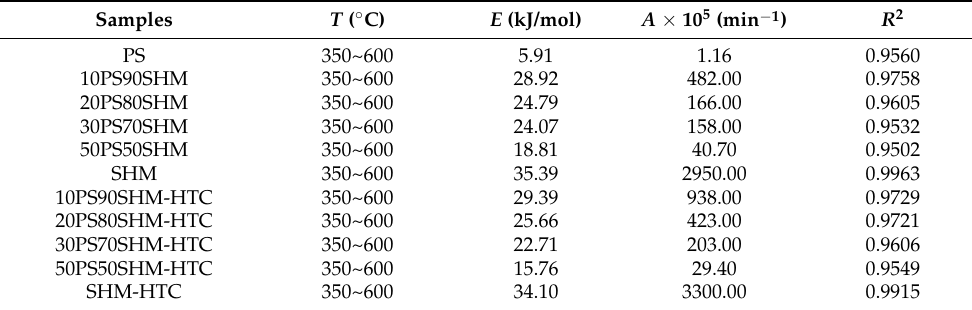
Table 4. Calculation results of kinetic parameters for PS, SHM, SHM-HTC and their